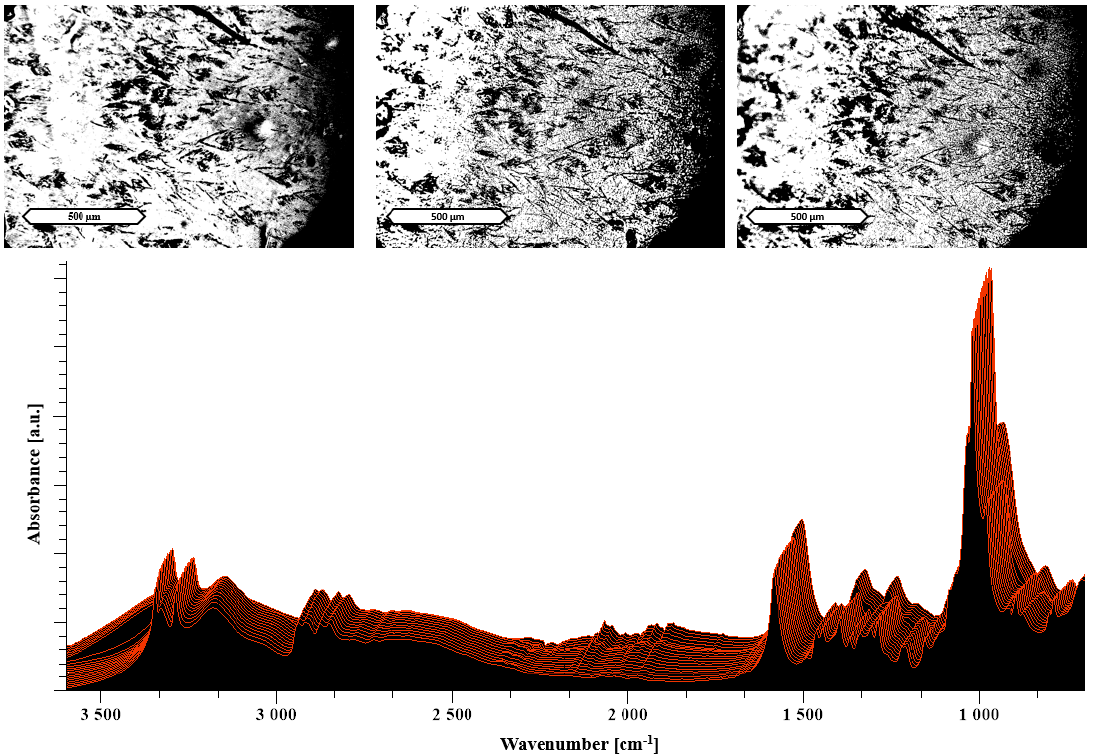
Figure 10. The images at the top show HSM images of 25% TRIS/NaCMC evaporated films taken at RT, 90 °C and 130 °C (from left to right). At the bottom, a temperature-resolved FTIR spectrum is shown. The displayed scale bar refers to 500 μ m. Each spectrum was measured at temperatures from 30 °C (measured first in the front) to 130 °C (in the back) by increasing steps of 5 °C.